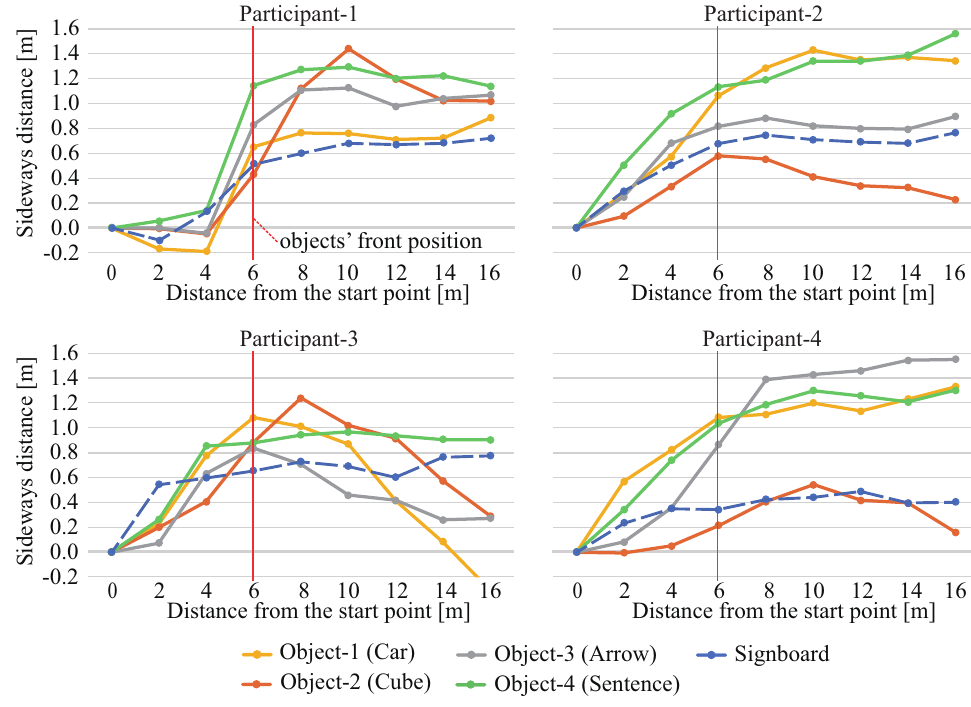
Figure 5. The results of four